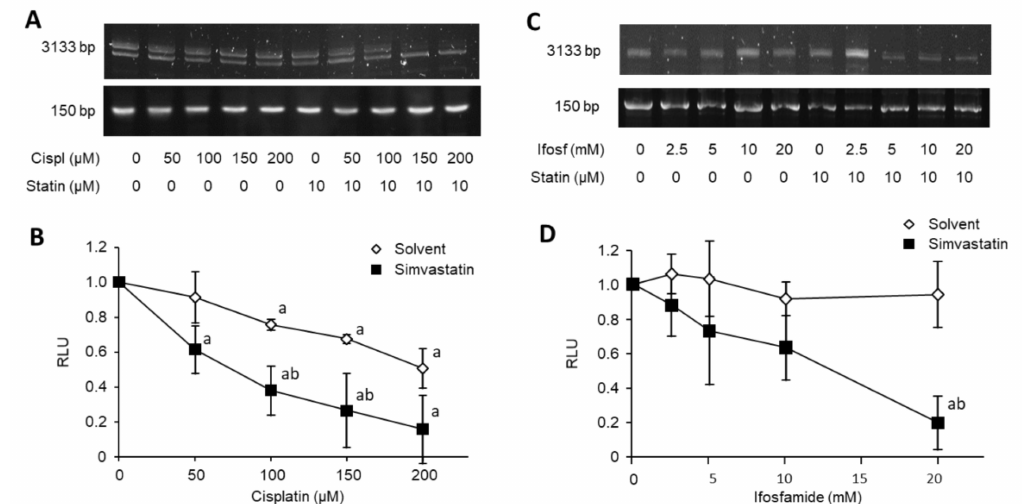
Figure 3. Simvastatin favors the formation of DNA adducts with cisplatin and ifosfamide. ( A – C ) Analysis of PCR products by agarose gel electrophoresis. Cells were exposed to increasing concentrations of cisplatin (A) or ifosfamide ( C ) for 1 h in the presence of simvastatin (10 µ M) or solvent. Genomic DNA was extracted and subjected to a PCR stop assay. ( B – D ) PCR amplification efficacy according to the indicated drug concentration for solvent- or simvastatin-treated cells. Results are expressed as mean ± SD ( n = 3) of relative quantification of a signal after normalization for the nested fragment. a: p < 0.05 vs. untreated, b: p < 0.05 vs. solvent.